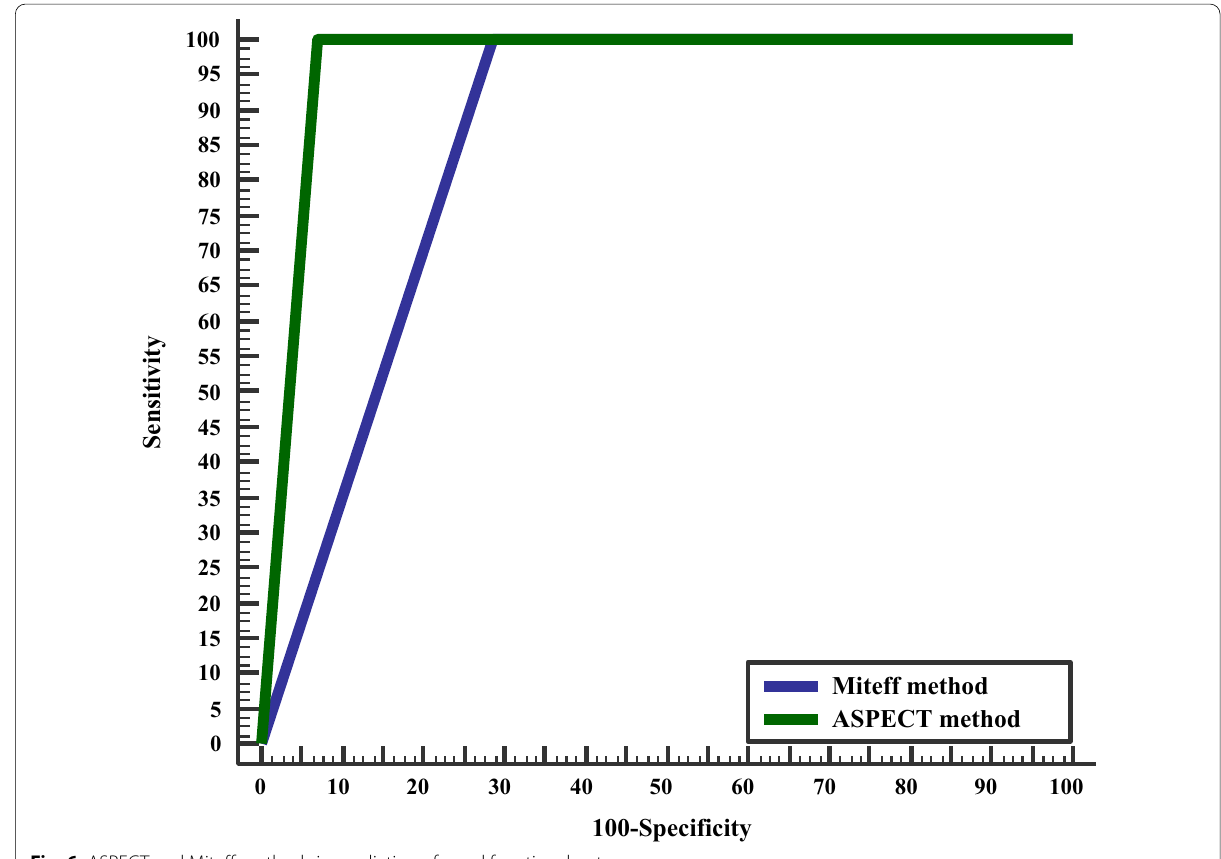
Fig. 6 ASPECT and Miteff methods in prediction of good functional outcome